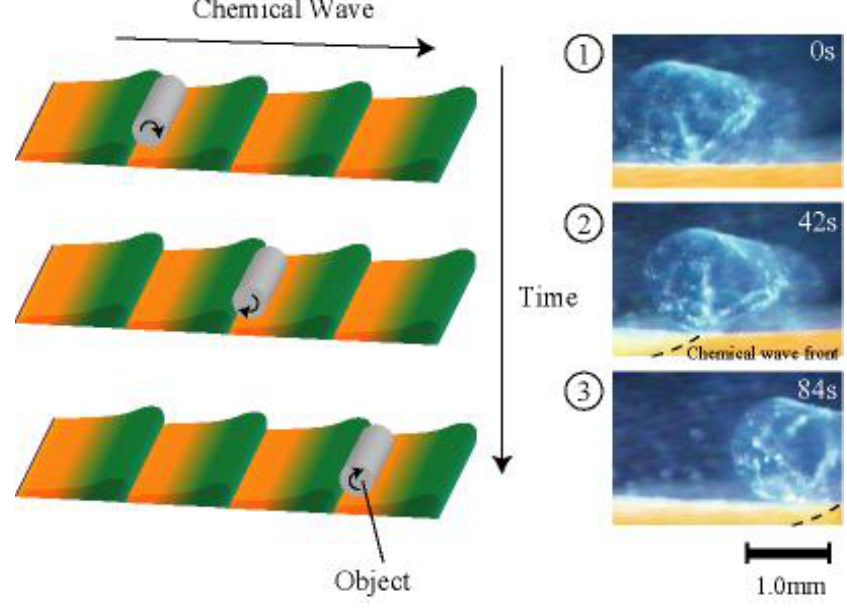
Figure 7. Schematic illustration of the matter transport using peristaltic motion of the gel. S. Maeda et al. Peristaltic motion of polymer gels. Angew. Chem. Int. Ed. 2008 , 47 , 6690-6693. Copyright Wiley-VCH Verlag GmbH & Co. KGaA. Reproduced